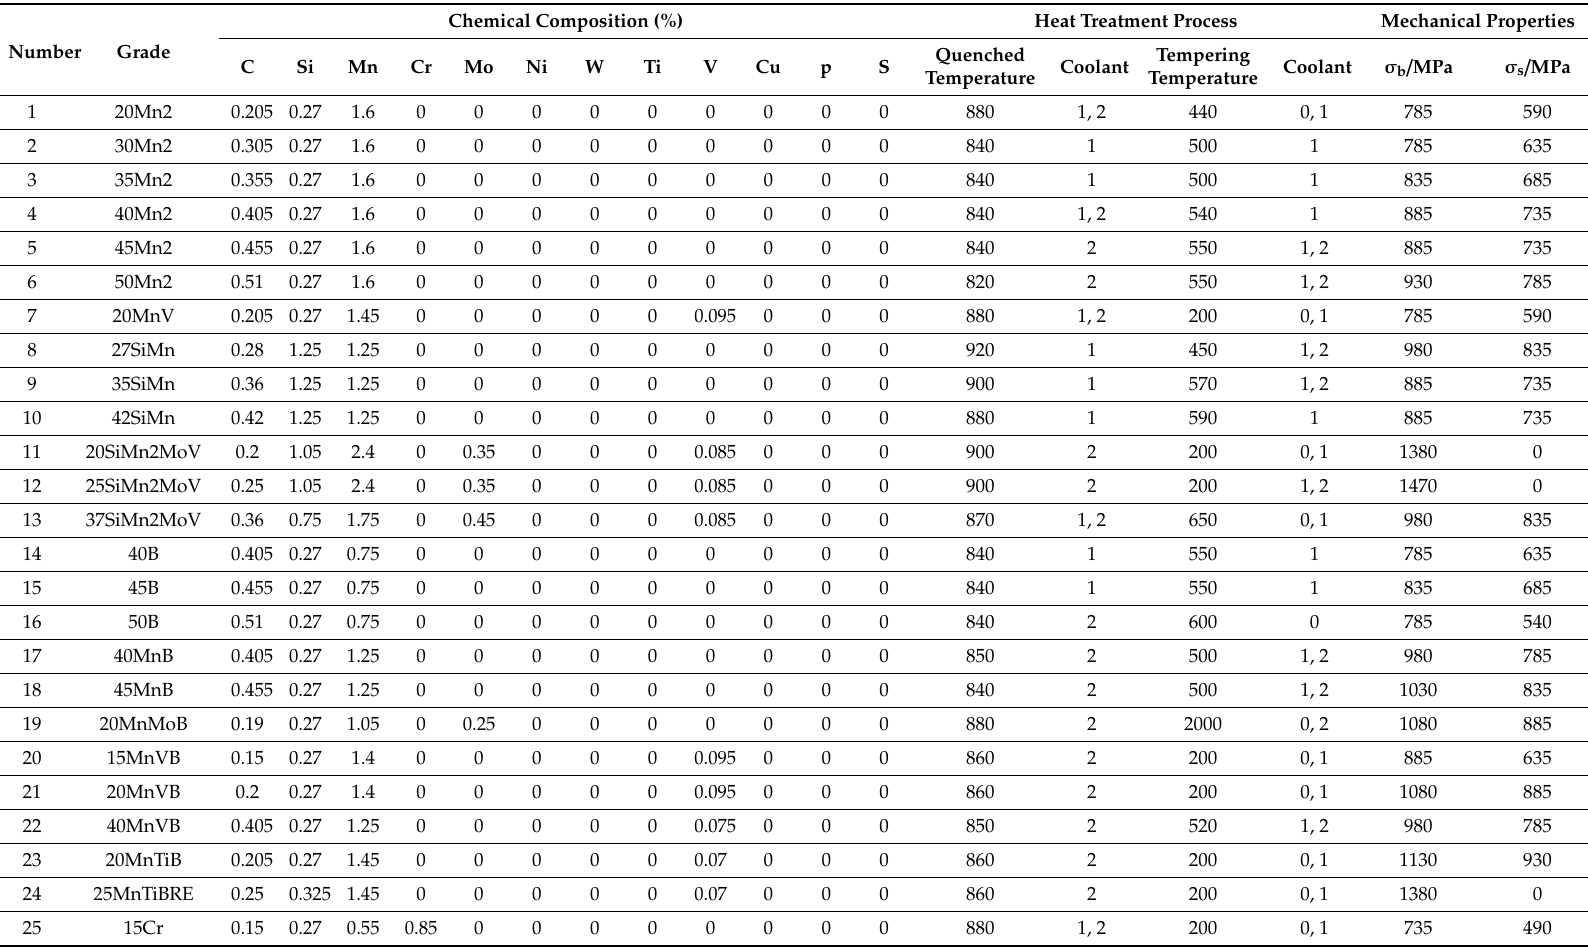
Table A1. Partial data of the ASM Alloy Center Database. (0 means air cooling, 1 means water cooling, and 2 means oil